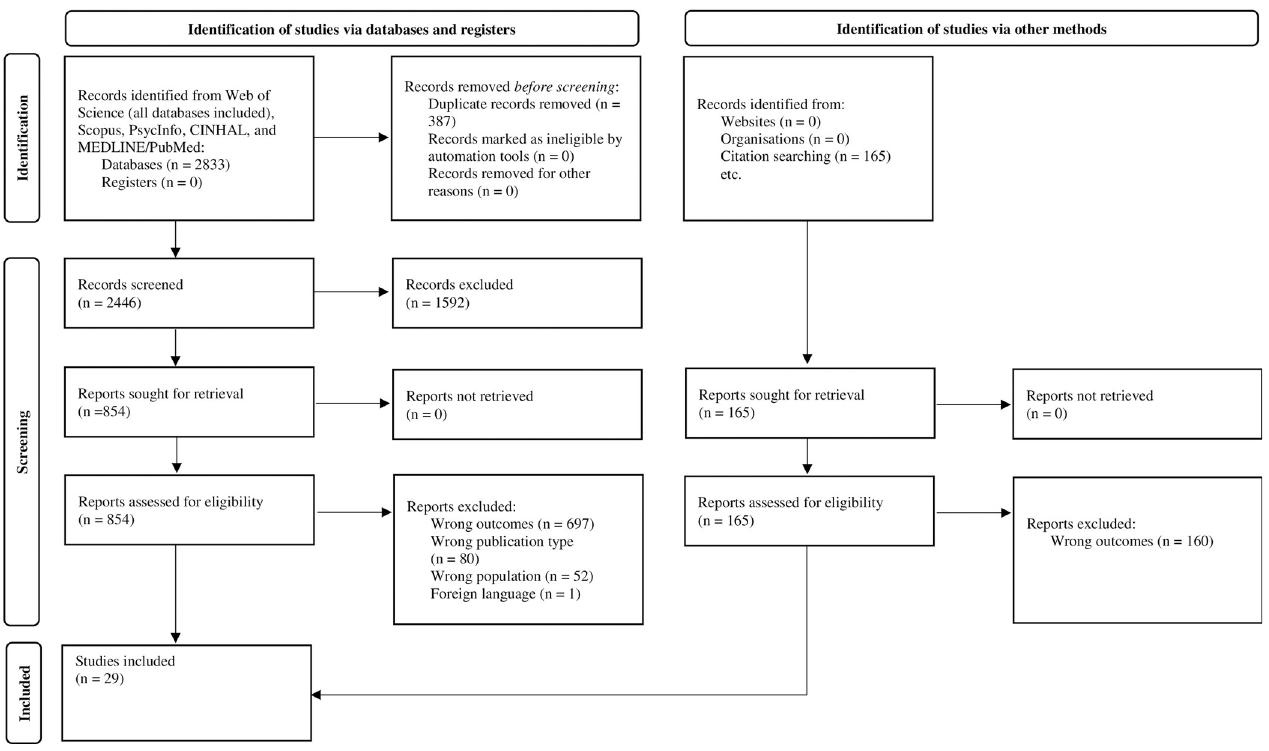
Fig 1. PRISMA 2020 flow